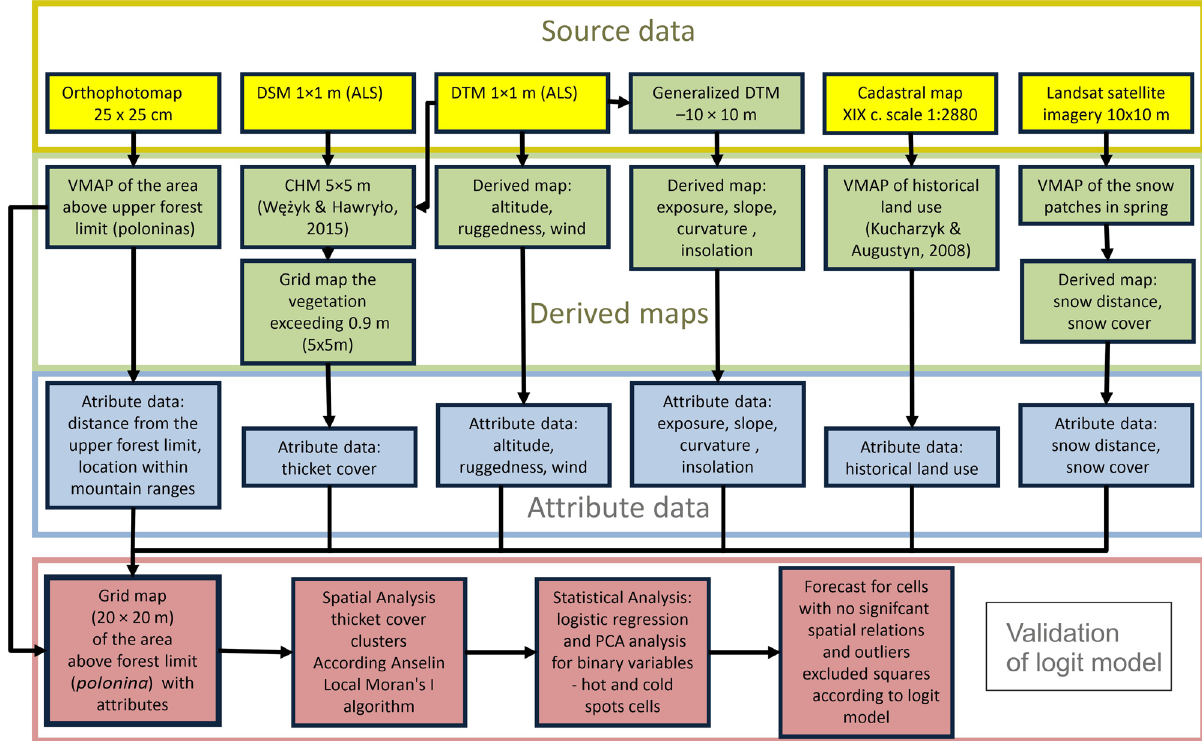
Figure 2. Flow diagram of the data handling. For details see Table 1.